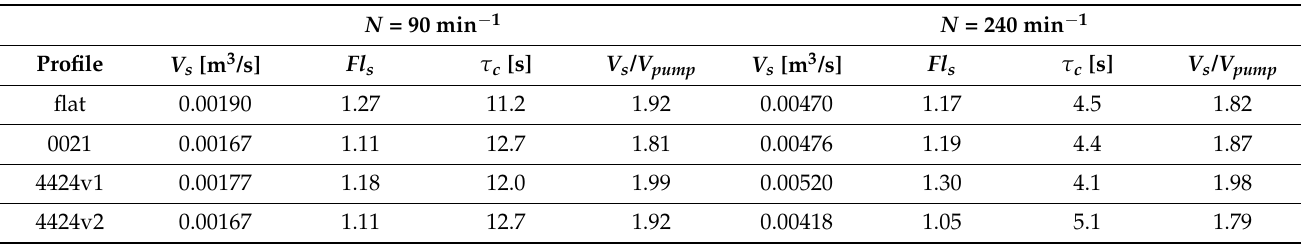
Table 5. Circulation